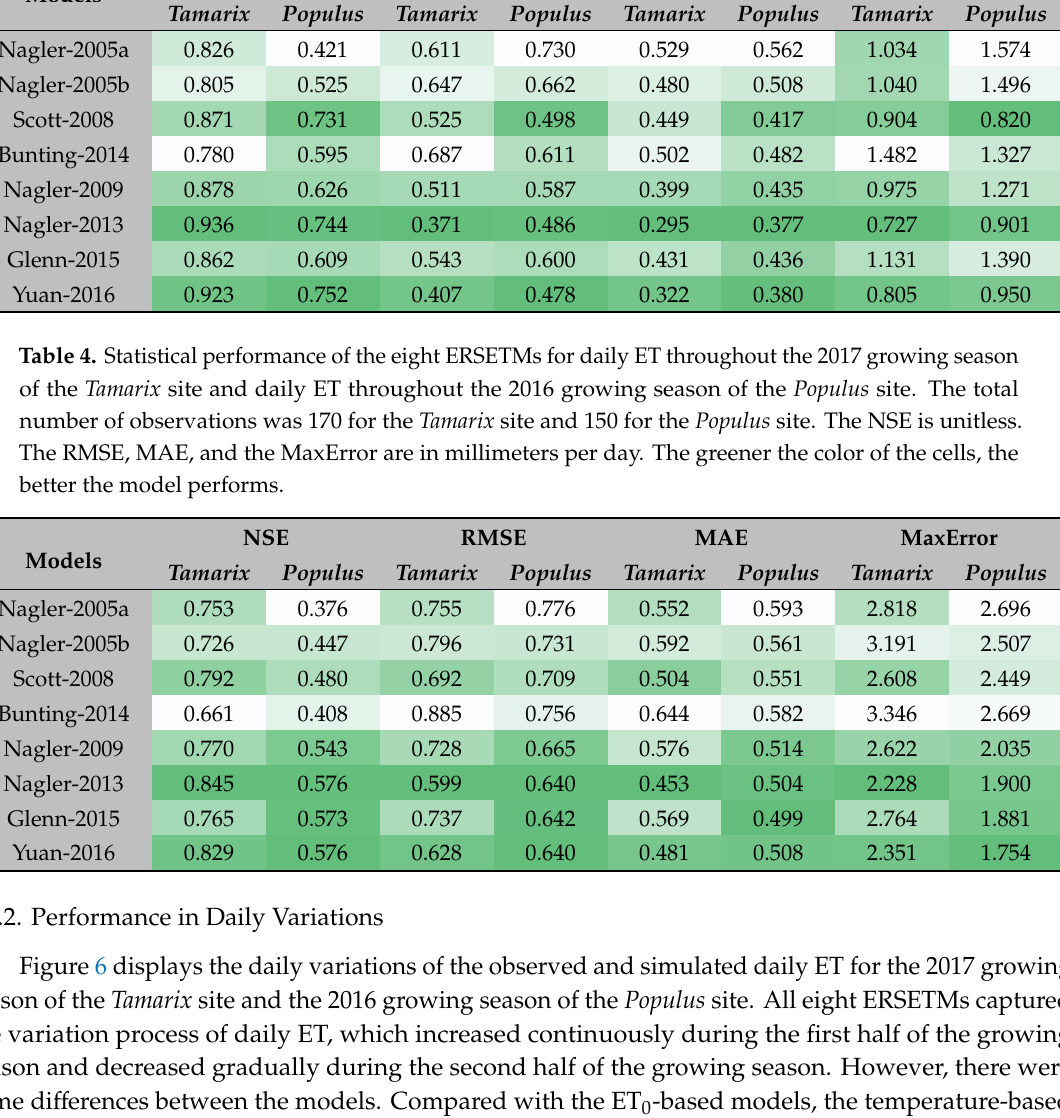
Table 3. Statistical performance of the eight ERSETMs for the validation dataset of the Tamarix site and the Populus site. The total number of observations was 9 for the Tamarix site and 11 for the Populus site. The Nash–Sutcli ff e e ffi ciency (NSE) is unitless. The root mean square error (RMSE), mean absolute error (MAE), and the maximum error (MaxError) are in millimeters per day. The greener the color of the cells, the better the model performs. NSE RMSE MAE